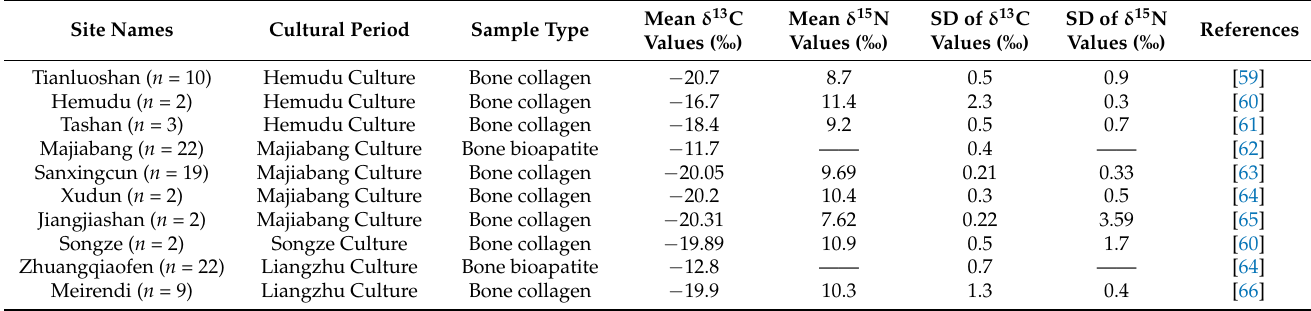
Table 1. Human bone δ 15 N and δ 13 C values from the 10 sites used in this